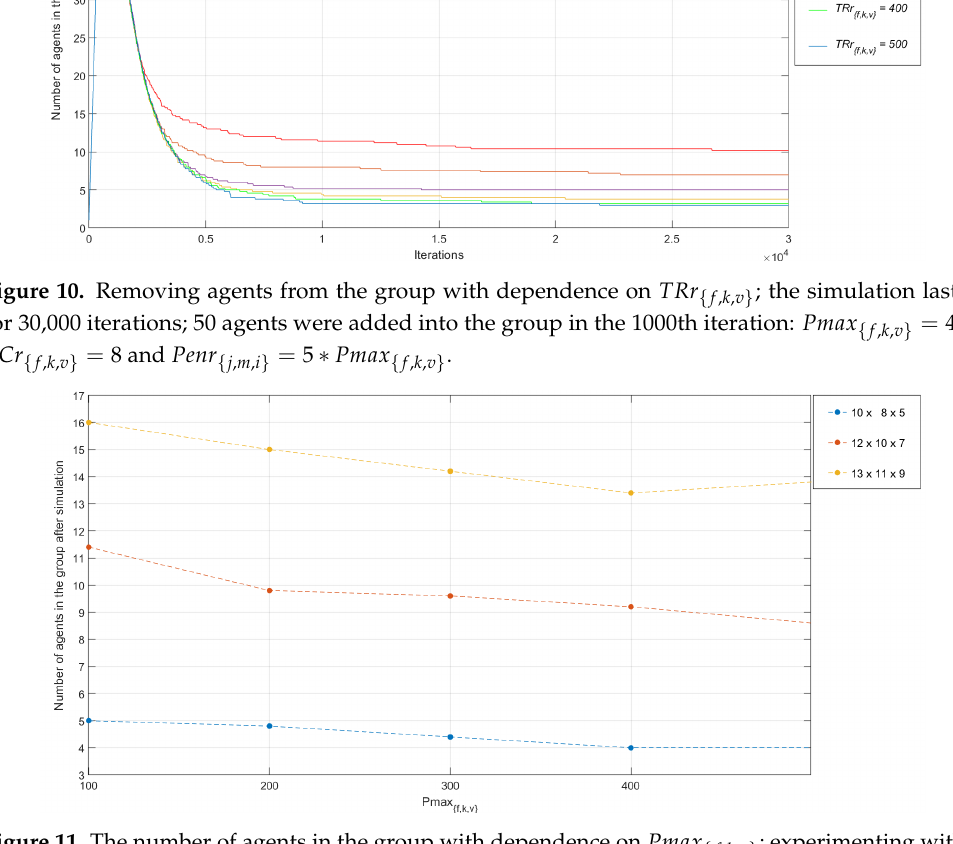
Figure 11. The number of agents in the group with dependence on Pmax { f , k , v } ; experimenting with a removing agents in various space sizes; 50 agents were added into the group in the 1000th iteration: TCr { f , k , v } = 8, TRr { f , k , v } = 200, and Penr { j , m , i } = 3 ∗ Pmax { f , k , v }